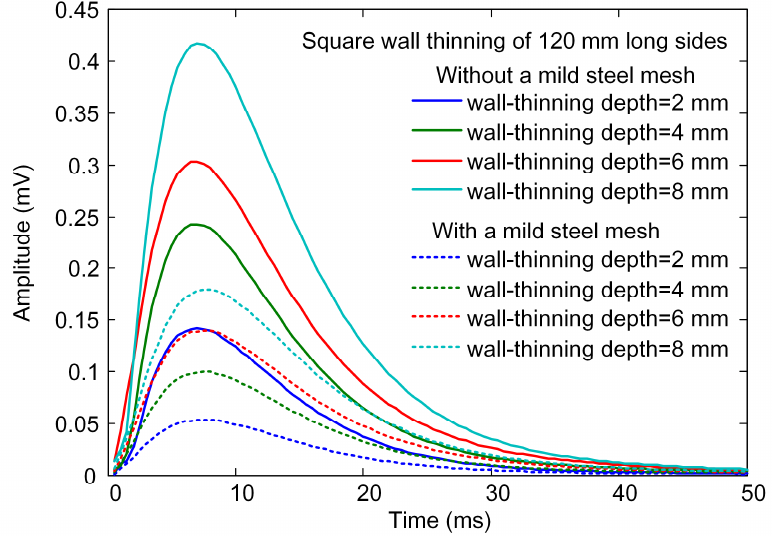
Figure 7. Simulated differential signals for the probe situated above the square wall thinnings having a side length of 120 mm and depths of 2 mm, 4 mm, 6 mm, and 8 mm, respectively.